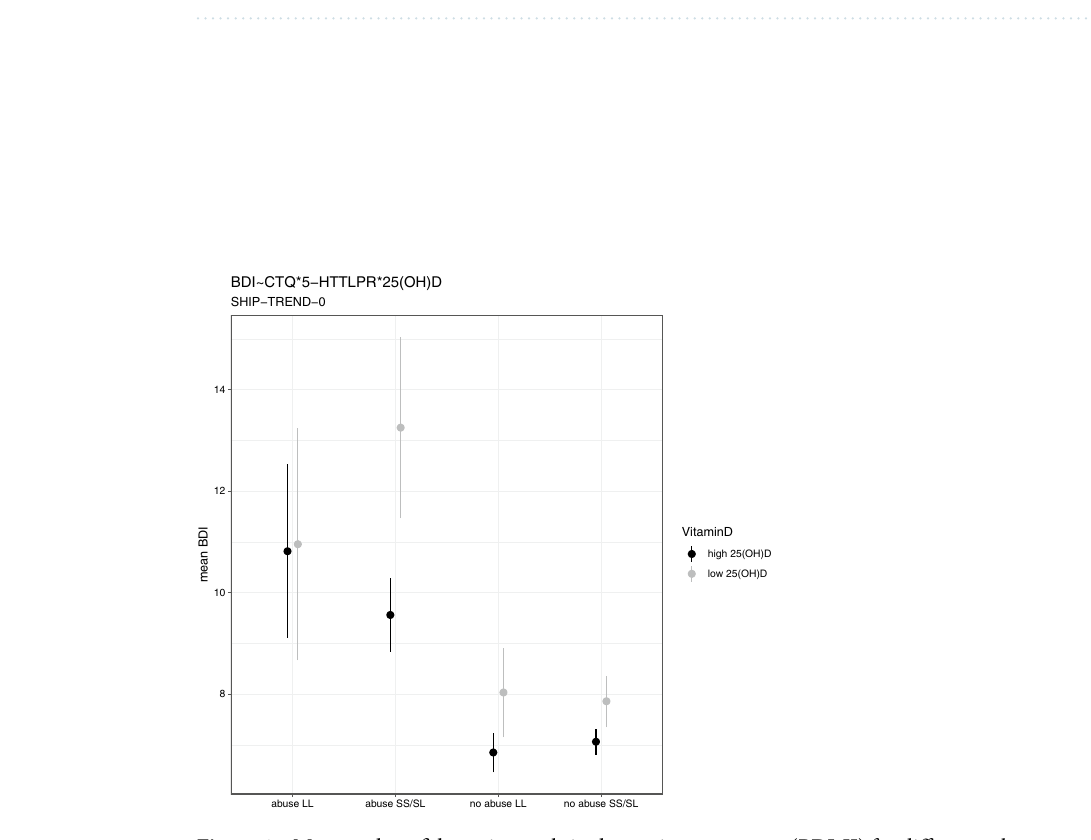
Figure 1. Mean and confidence intervals in depression symptoms (BDI-II) for different subgroups of the three- way interaction childhood trauma questionnaire (CTQ, abuse vs. no abuse), 5-HTTLPR (LL vs. SL/SS)